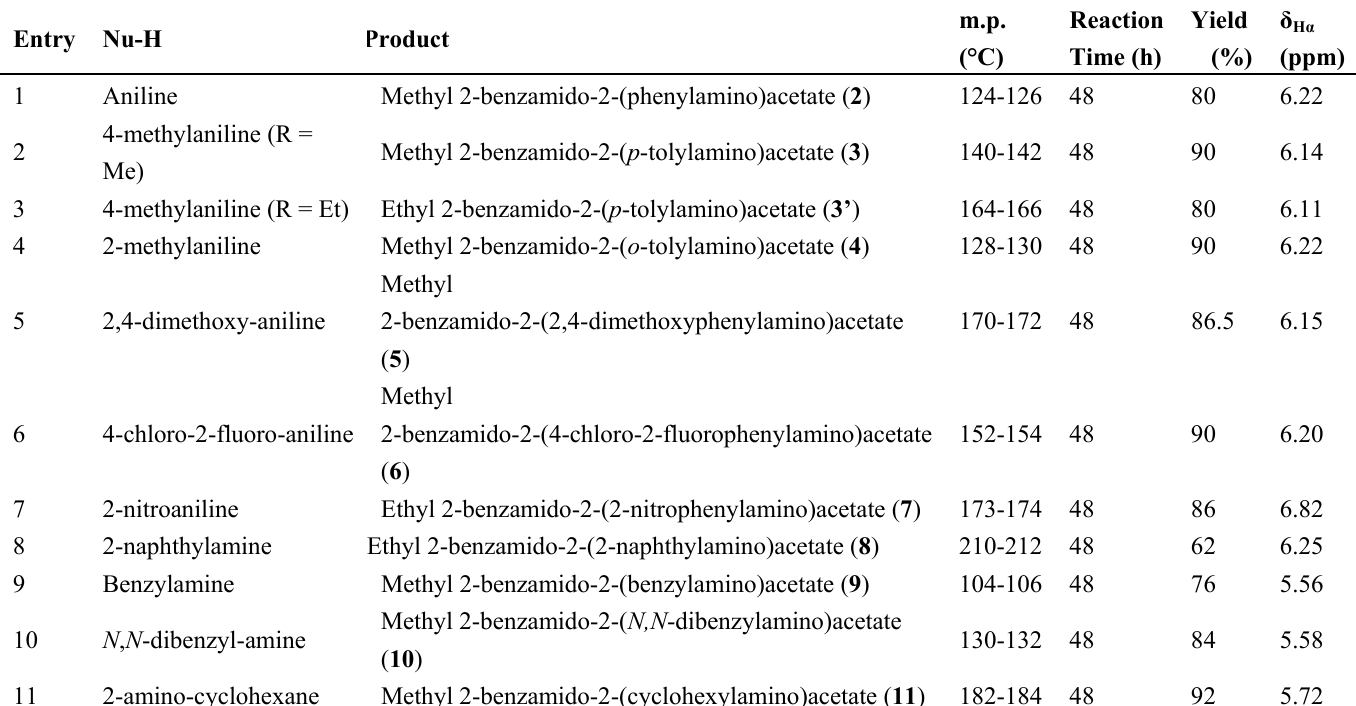
Table 1. Synthesis of new methyl or ethyl α -aminoglycinates derivatives 2 - 11